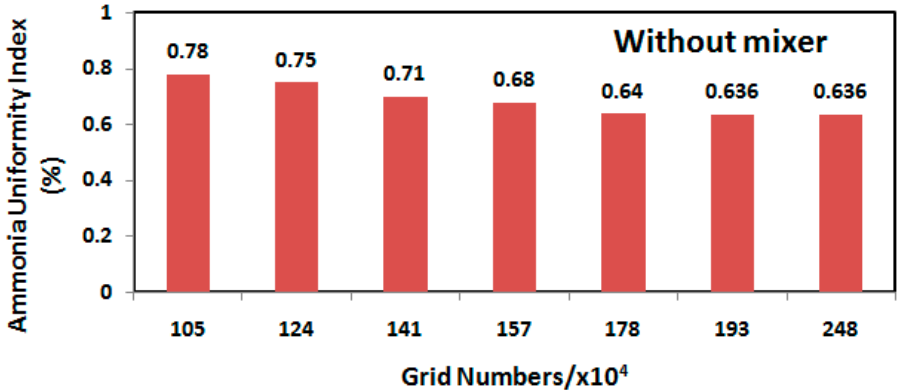
Figure 3. Mesh grid independence analysis.